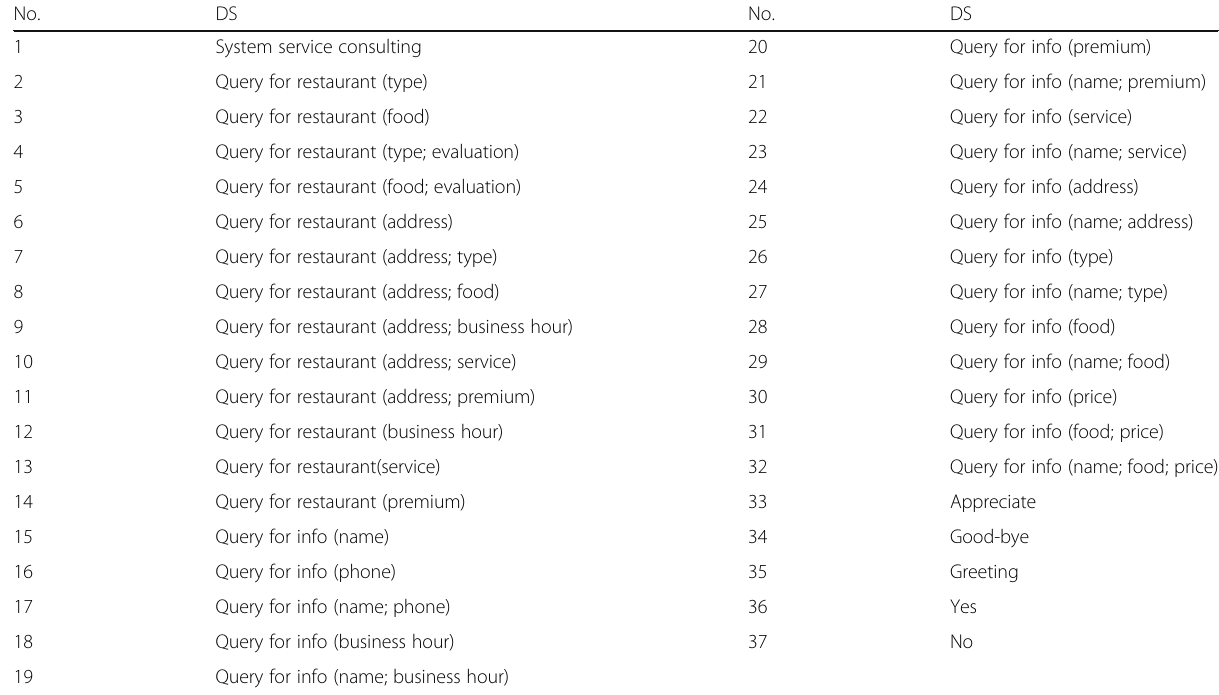
Table 2 The predefined 37 Base DSs with predicate and optional arguments